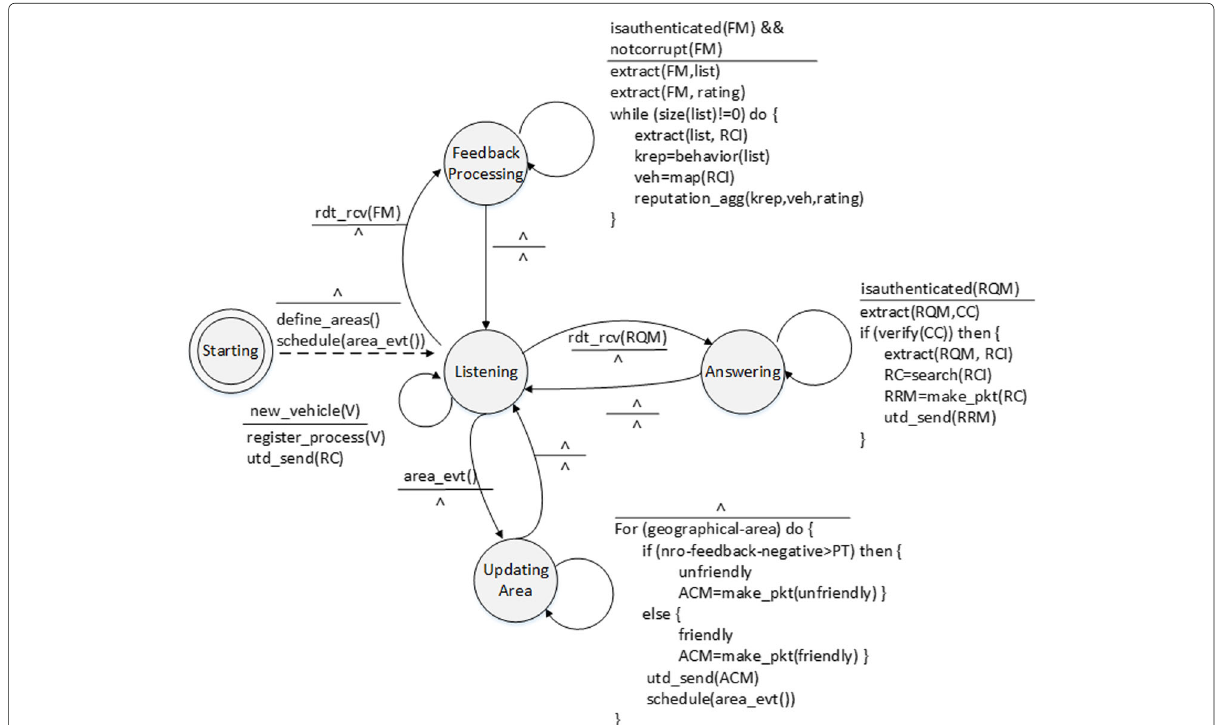
Fig. 5 Finite state machine of the reputation